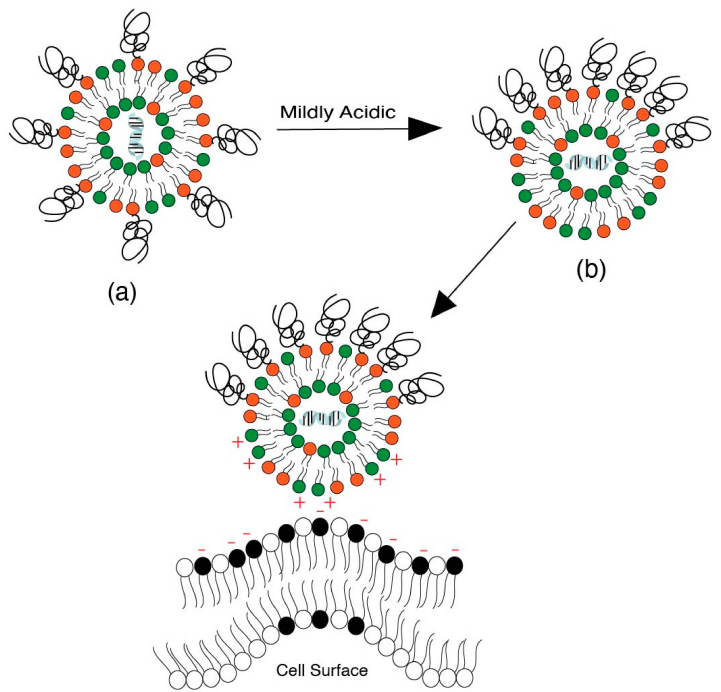
Figure 13. Convertible liposomes that show phase separation of lipids on Liposomal surface [9]. ( a ) Liposomes with uniformly distributed PEGylated lipids on the liposome surface at physiological pH. ( b ) Phase separation of lipids, which leads to formation of domains with a high concentration of PEG lipids on the liposome surface that in turn leads to increased interactions with the negatively charged cell